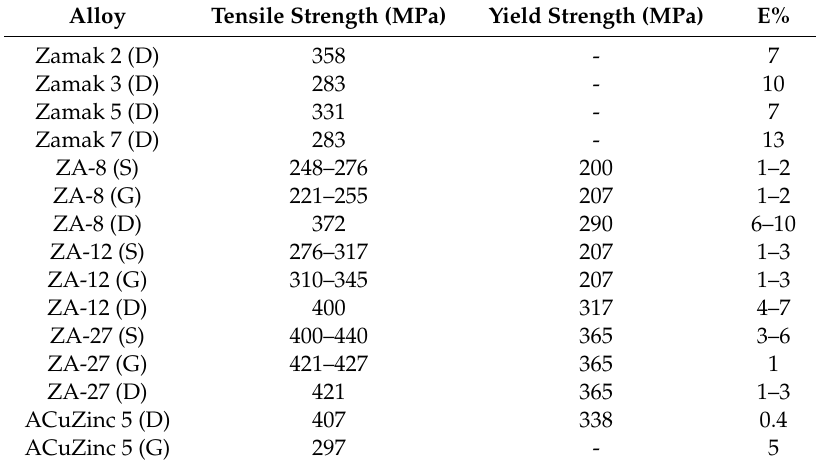
Table 2. Mechanical properties of some zinc-base alloys